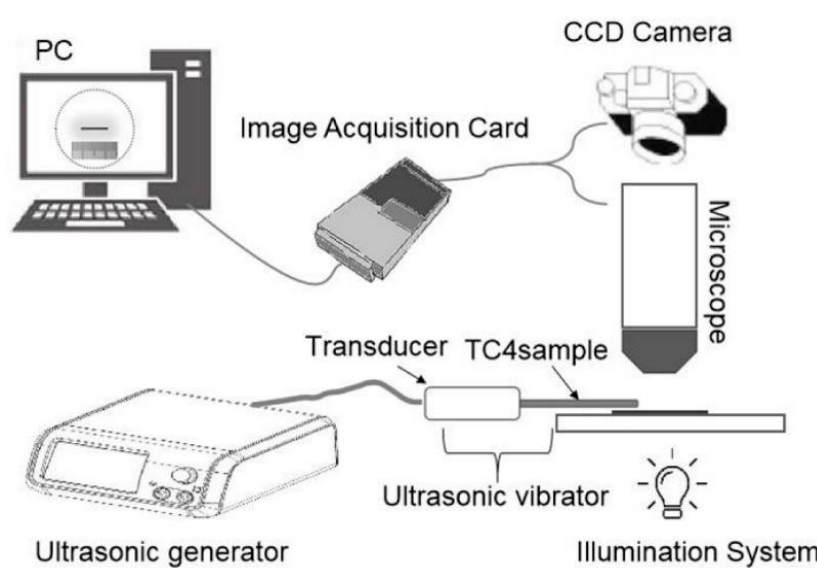
Figure 2. The schematic diagram of the ultrasonic amplitude measurement of the Ti6Al4V vibrator.